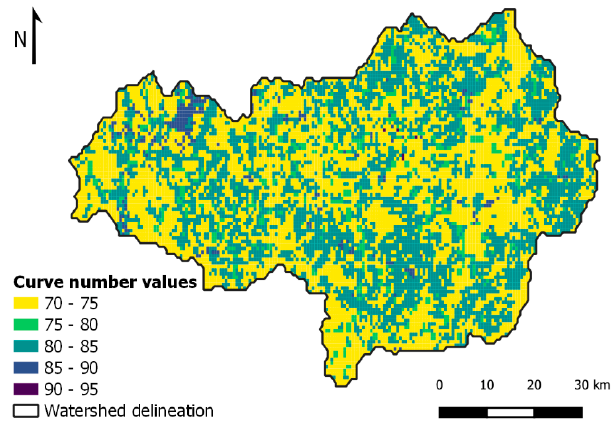
Figure 5. Curve number values.